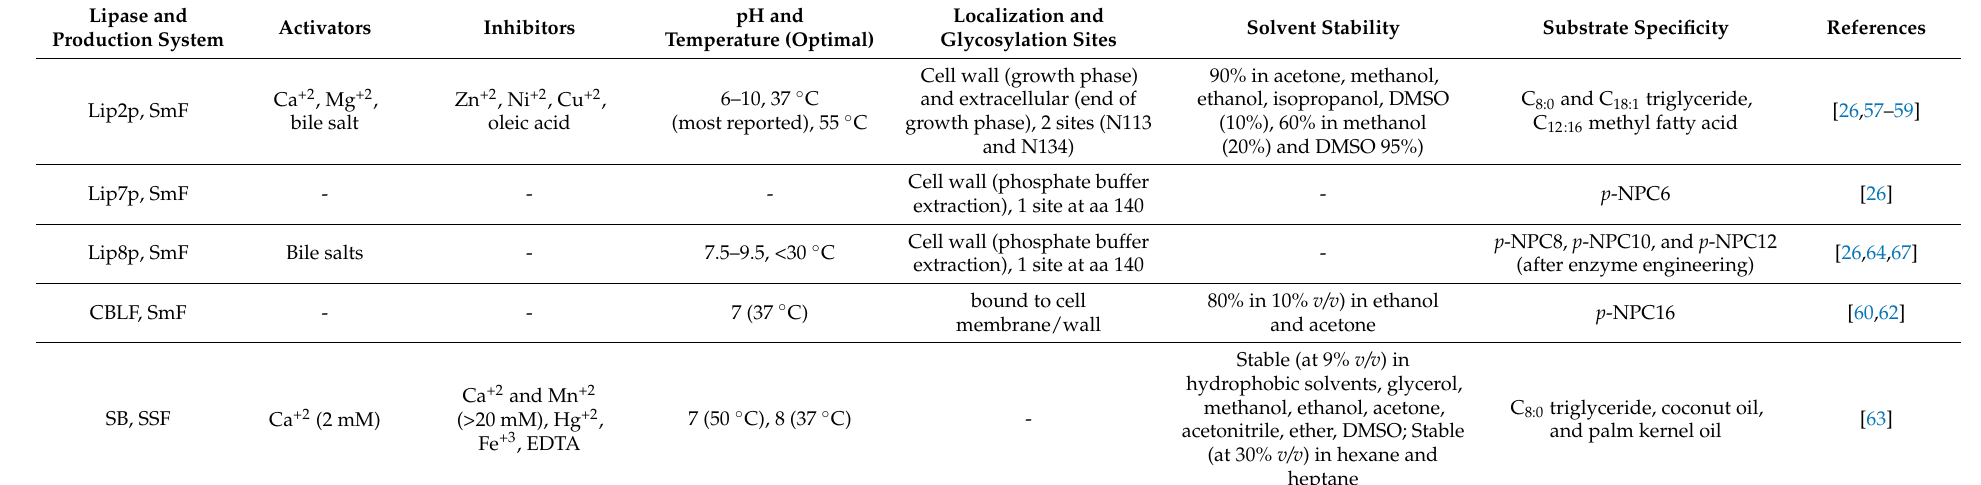
Table 2. Compilation of general features of lipases from Yarrowia lipolytica